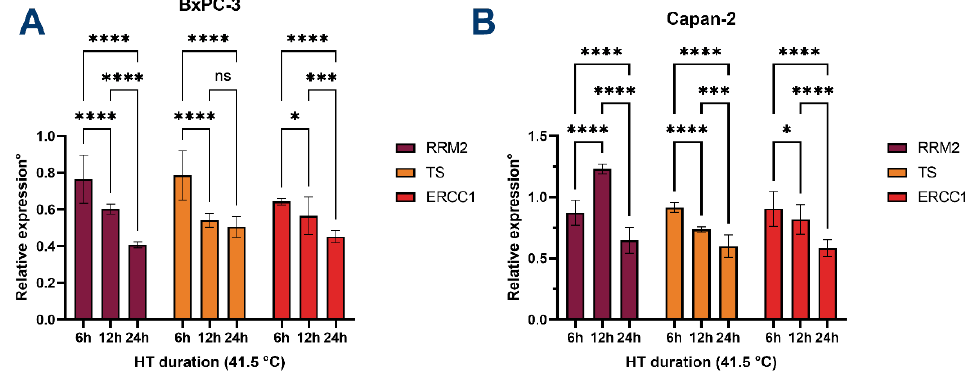
Figure 7. Hyperthermia leads to downregulation of RRM2, TS, and ERCC1. Relative expression of RRM1, TS, and ERCC1 in ( A ) BxPC-3 cells and ( B ) Capan-2 cells. Expression is normalized to GAPDH and calculated relative to cells incubated at 37 ◦ C. Statistical significance ns = not significant; * p < 0.05; *** p < 0.0001; **** p <